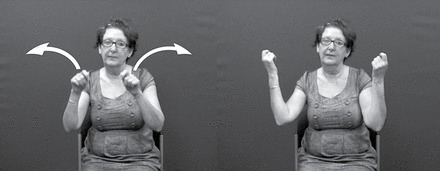
BSL NEWSPAPER (photo originally published in Cormier et al., 2012).